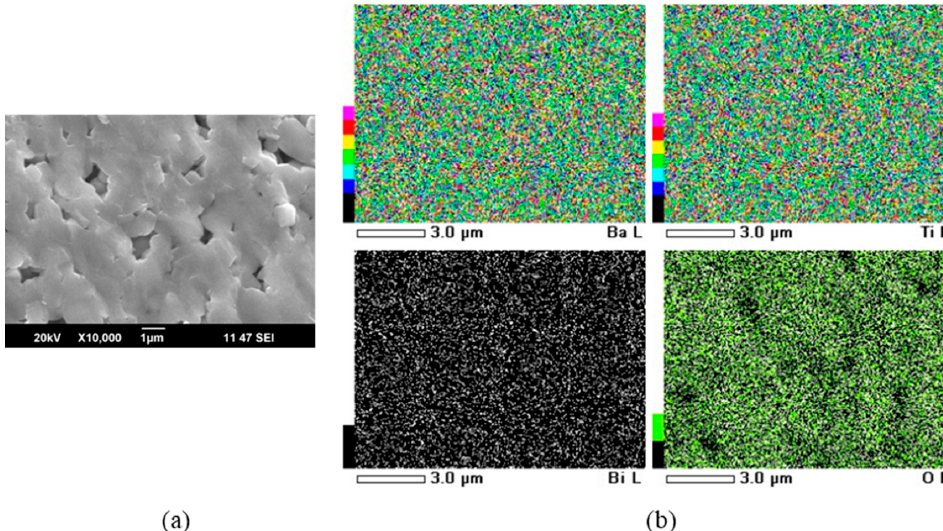
Figure 5. SEM image ( a ) of fractured BaTiO 3 ceramics doped with 5.0 mol % Bi 2 O 3 and its EDX mapping images ( b ) for the following elements: Ba, Ti, Bi, and O.